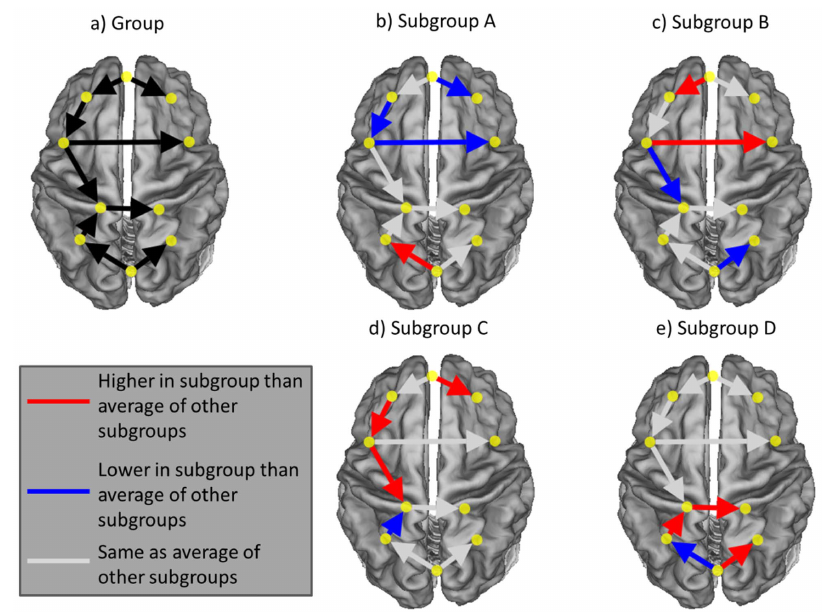
Figure 4. Patterns of effects used to simulate data and results.